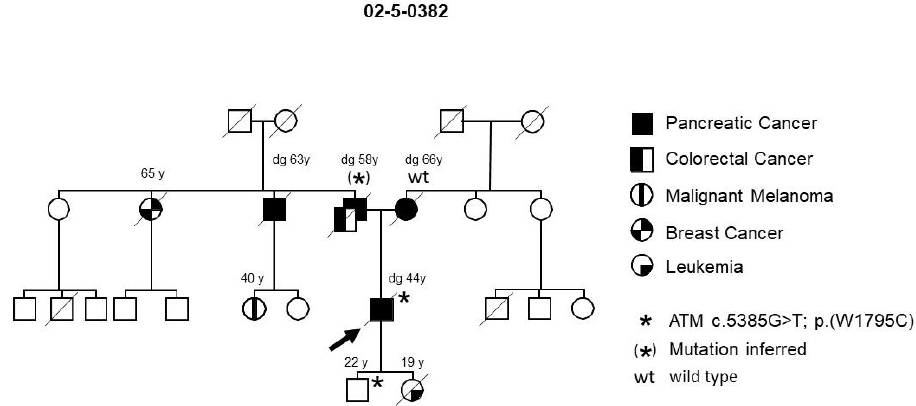
Figure 1. FPC family with an ATM germline variant. The arrow designates the index patient. Diagonal lines indicate deceased individuals.